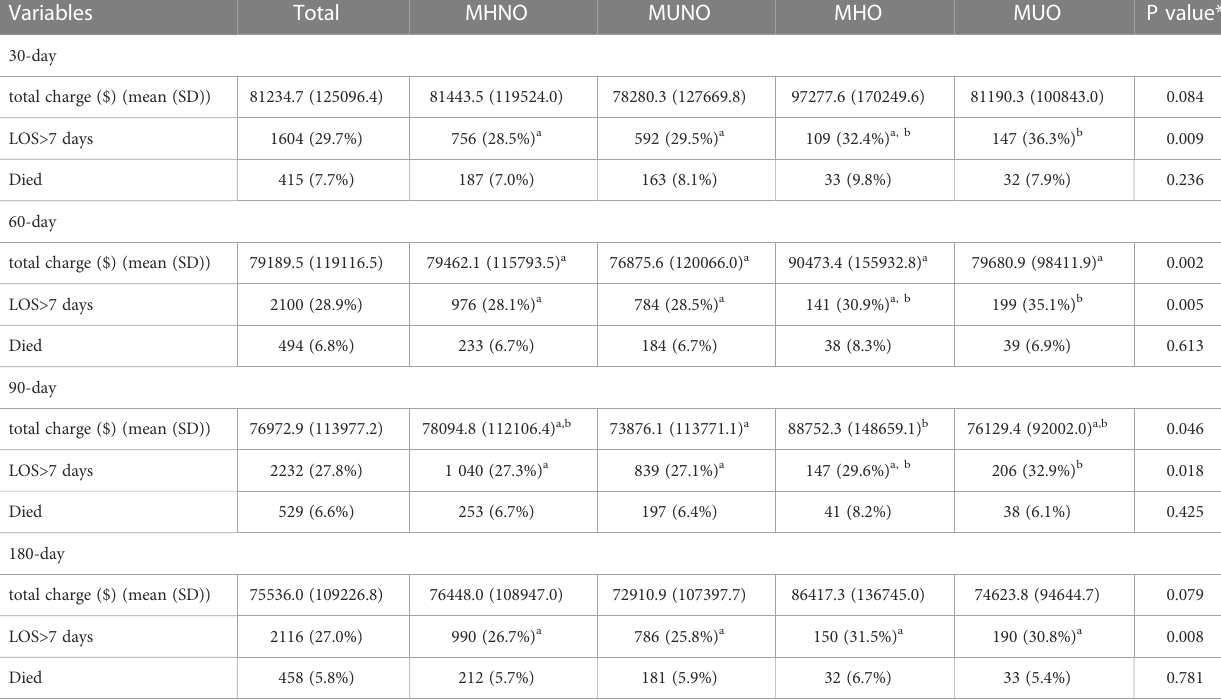
TABLE 3 Death and healthcare during